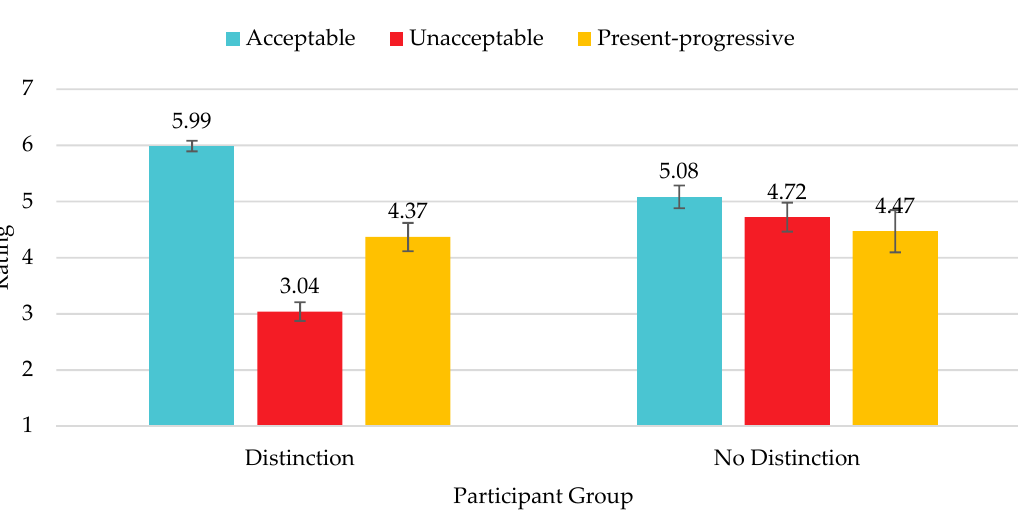
Figure 3. Mean rating of all stimuli by participant group and stimulus type.